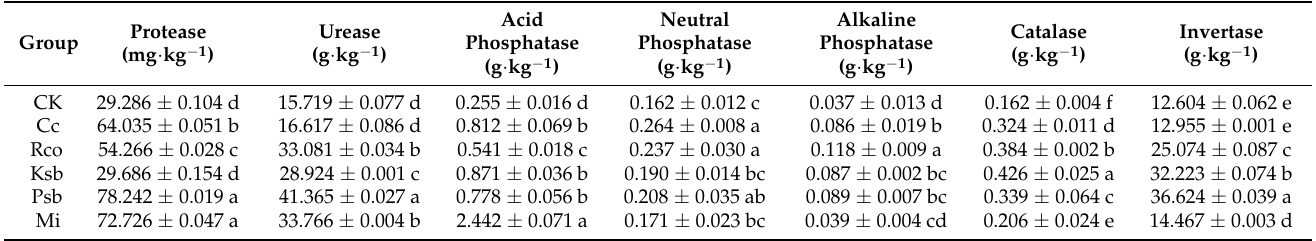
Table 3. Effects of different microbial inocula on rhizospheric soil enzyme activity of F. taipaiensis